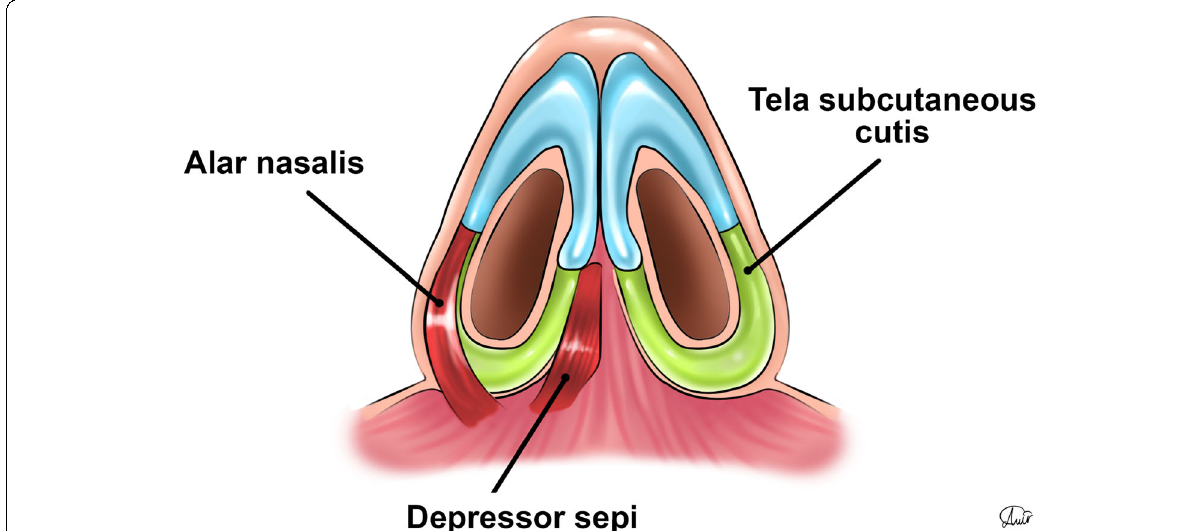
Fig. 12 Tela subcutanea cutis, depressor septi nasalis muscles can be seen from basal view; mytriformis and dilator naris cannot be seen from this